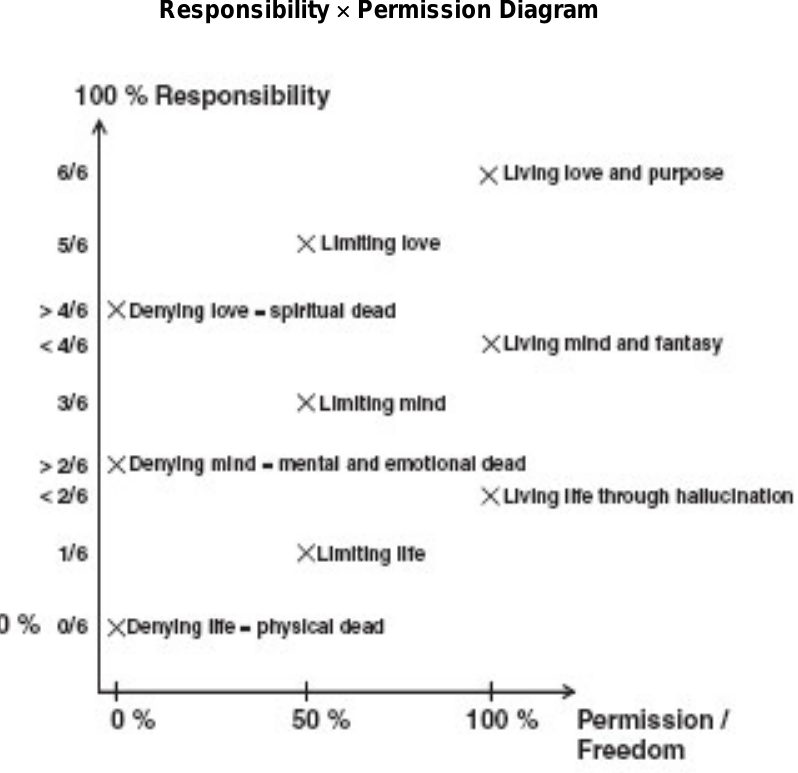
Responsibility × Permission